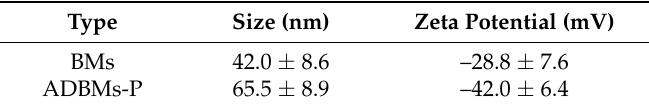
Figure 1. TEM images of: bacterial magnetosomes (BMs, a ); and ADBMs-P ( b ). Black arrows showL uniform and clear lipid membranes of BMs ( a ); and thickened and blurred membranes of ADBMs-P ( b ). Table 1. Size and zeta potential of BMs and ADBMs-P.